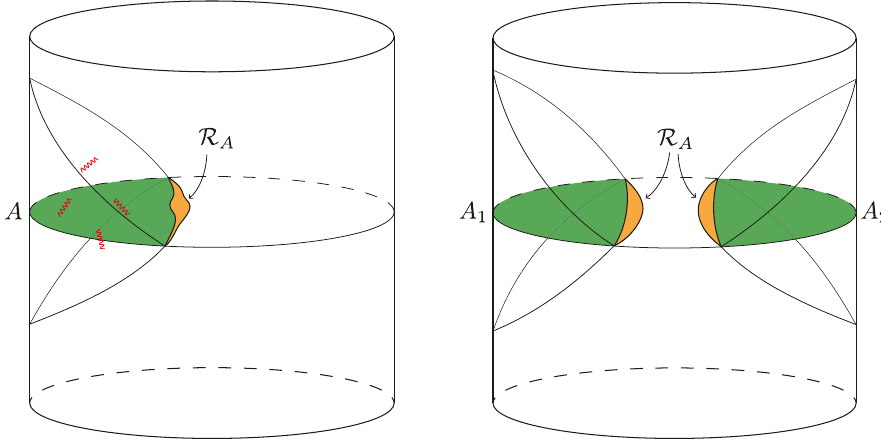
Figure 5 . Left: when the boundary region is a spherical cap, the entanglement wedge and the causal wedge agree in the vacuum, but small perturbations to the state with h T will generate µν i ∼ c a small gap between them. The green region is the a slice of the causal wedge and the orange region is bounded by the causal surface and the RT surface R and its domain of dependence is P [ A ] . A Right: in pure AdS, a boundary region A = A , a union of two disjoint spherical caps is shown. 1 ∪ A 2 Due to the bulk entanglement between the disjoint components of the causal wedge, the outermost quantum extremal surface R bulges inwards from the causal surface by an amount proportional A to cG . Note that if A is large, the RT surface will be different from R N A